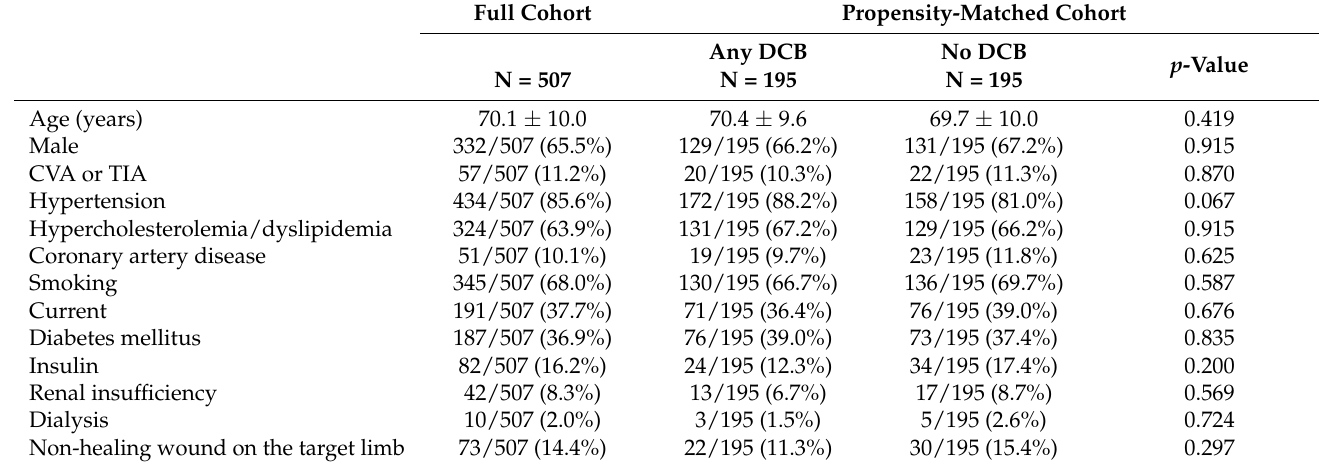
Table 1. Baseline